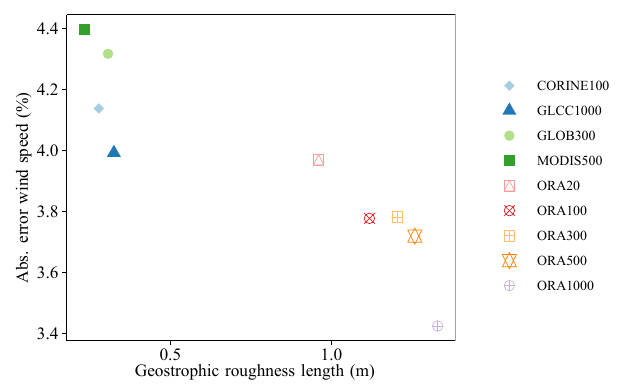
Figure 8. Mean absolute error in wind speed as a function of the geostrophic roughness length when using the default WAsP settings but with the roughness change model switched off.